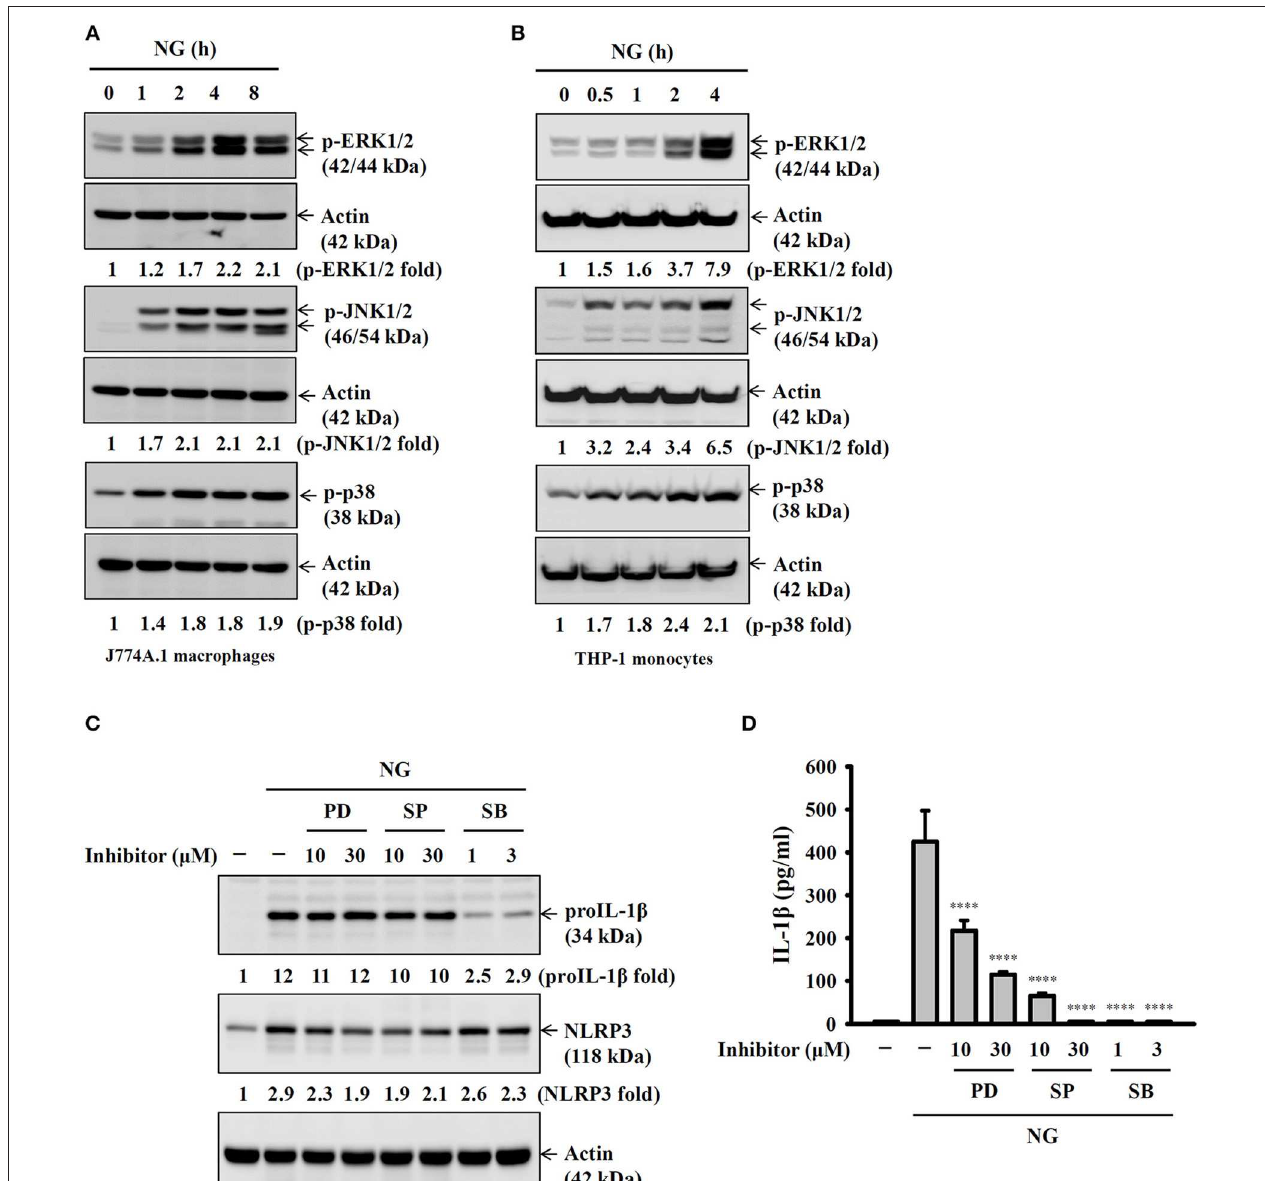
FIGURE 5 | Activation of the NLRP3 inflammasome by NG through MAPK-dependent pathways. (A,B) J774A.1 macrophages were infected for 0–8h with NG at 50 MOI (A) or THP-1 monocytes were infected for 0-4h with NG at 20 MOI (B) . The amounts of phosphorylated ERK1/2, JNK1/2, and p38 in the cell lysates were measured by Western blotting analysis. (C) J774A.1 macrophages were incubated for 0.5h with PD, SP or SB, followed by infection for 8h with NG at 50 MOI. The levels of proIL-1 β and NLRP3 in the cell lysates were measured by Western blotting analysis. (D) J774A.1 macrophages were incubated for 0.5h with PD, SP or SB, followed by infection for 24h with NG at 50 MOI. The levels of IL-1 β in the supernatants were measured by ELISA. The ELISA data are expressed as the mean ± SD of three separate experiments. The Western blotting results are representative of three different experiments, and the band intensity was analyzed by ImageJ and expressed as the fold change compared with the mock control group normalized to actin. A significant difference at the level of **** p < 0.0001 compared to NG-infected cells (One-way ANOVA with Dunnett’s multiple comparisons test).